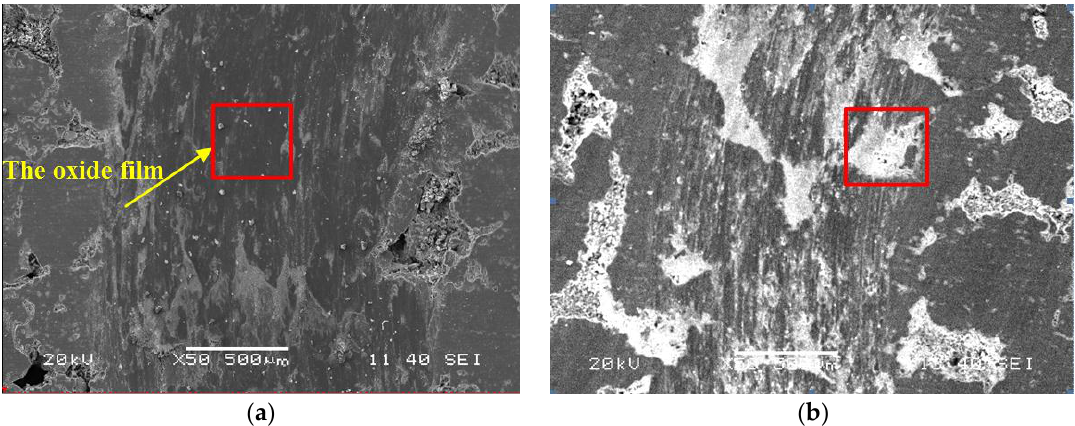
Figure 14. SEM images showing the surface morphology of porous titanium materials at different temperatures: ( a ) the temperature of the sample is 300 °C; and ( b ) the temperature of the sample is 500 °C.